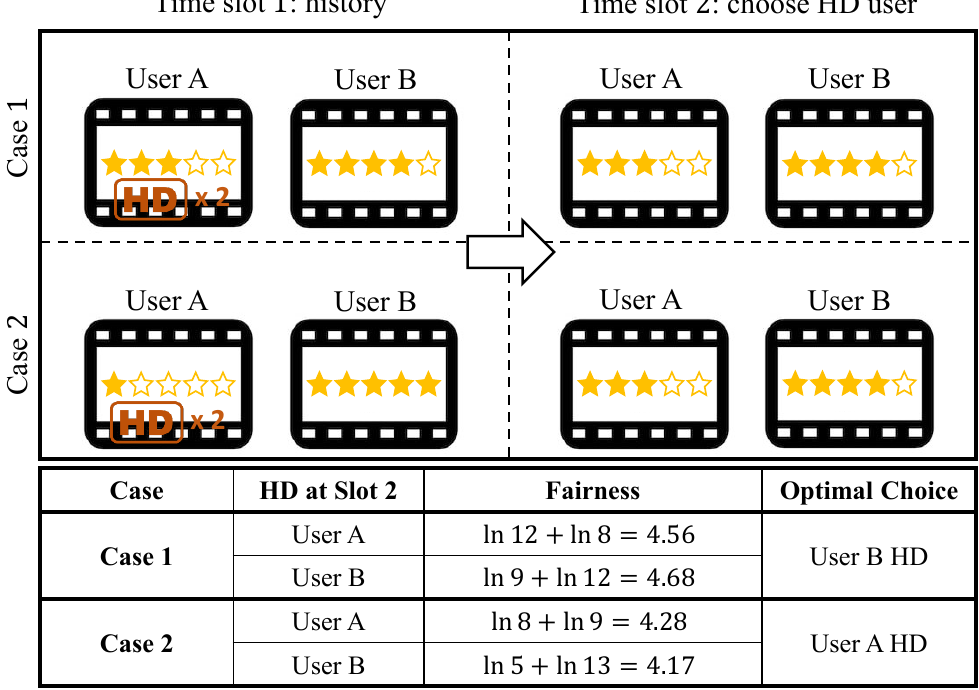
Figure 1. An illustrative example showing that the optimal choice of bandwidth assignment must depend on past rewards/states in order to maximize a logarithmic fairness